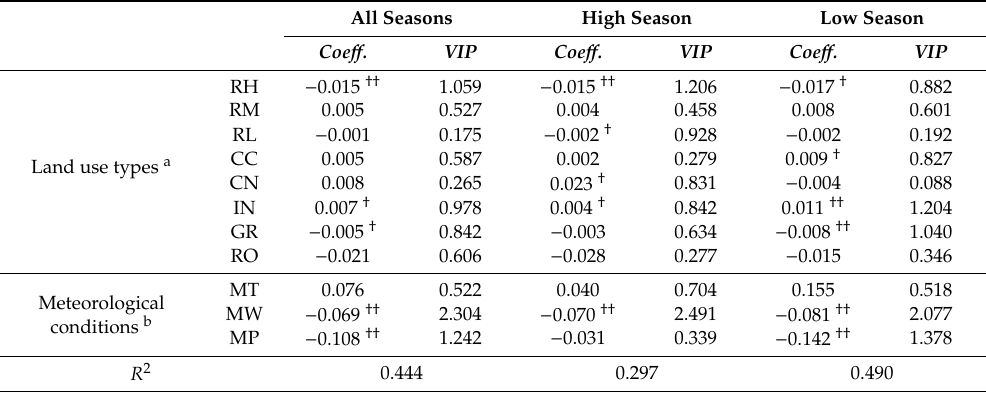
Table 6. Estimation of PM 2.5 levels based on land use classification II using PLS regression models. All Seasons Coe ff . Coe ff